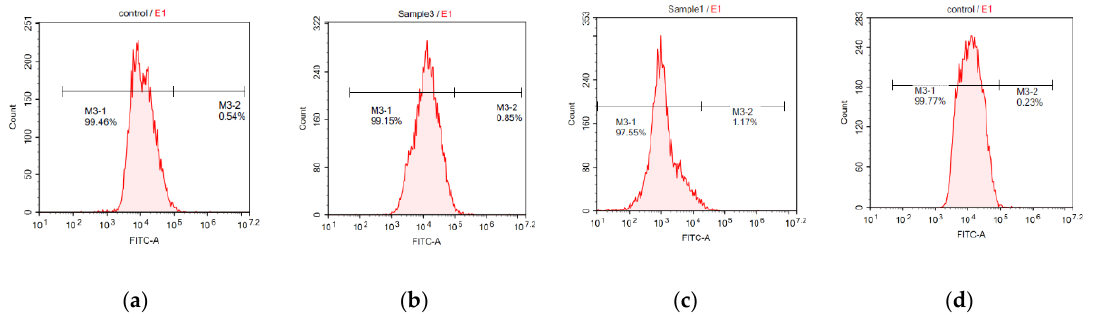
Figure 7. Flow cytometry analysis of CCD-18Co cells incubated with ( a ) TbPO 4 ·H 2 O@silica-NH 2 ; ( b ) TMC , ( c ) CD133-FITC; and ( d ) negative control using a Novocyte flow cytometry system and NovoExpress software (ACEA Bioscience Inc.).